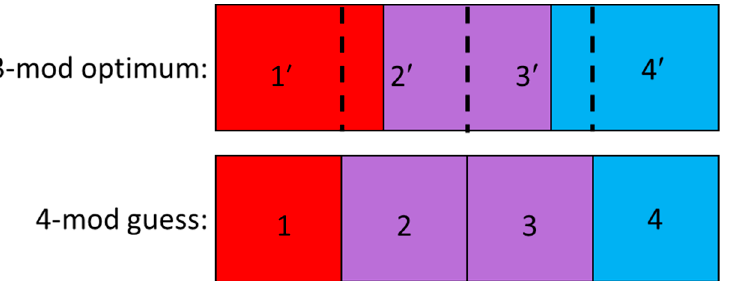
Figure 10. An example of how a one-to-one comparison can be performed to determine the similarity of performances between an optimum solution and the guess generated by it.